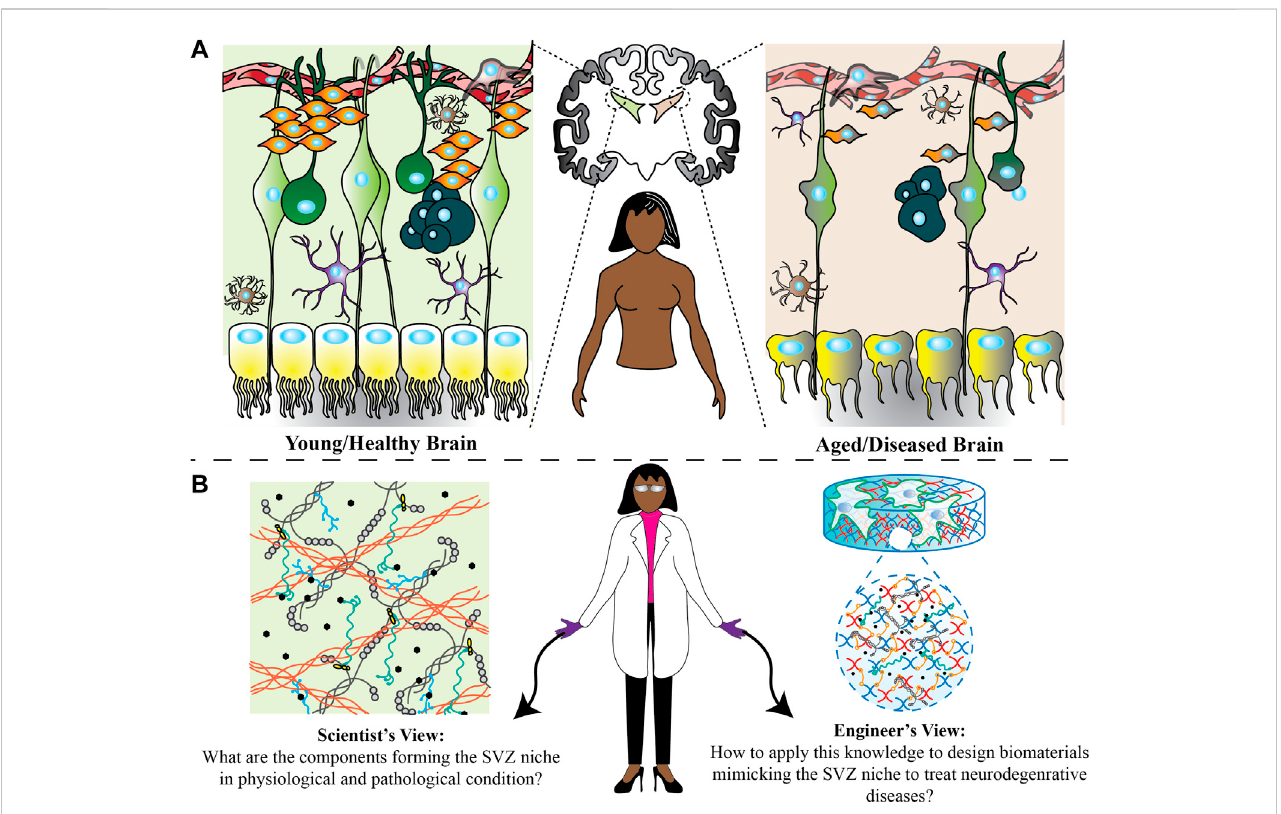
PossiblechangeshappeningintheSVZregioninphysiologicalandpathologicalconditions. (A) Throughpathologicalconditions,theshapeofependymal cells changes from cubical to more fl attened with scattered cilia. Furthermore, residing astrocytes and microglia undergo functional and morphological changes. There are also fewer numbers of neural stem cells, progenitor cells and neuroblasts in an aged/diseased brain. All of these could be the potential reasonsfor brainfunctionchanges. (B) Scientists andengineerscandevelopnewtreatmentideas fromtwodifferentperspectives.Scientists can fi ndout how these changes affect the microenvironment homeostasis and engineers can use this information to design a microenvironment in vitro to understand how every single factor change can affect the neural stem cell fate decisions, and ultimately examine in vivo how factors can be